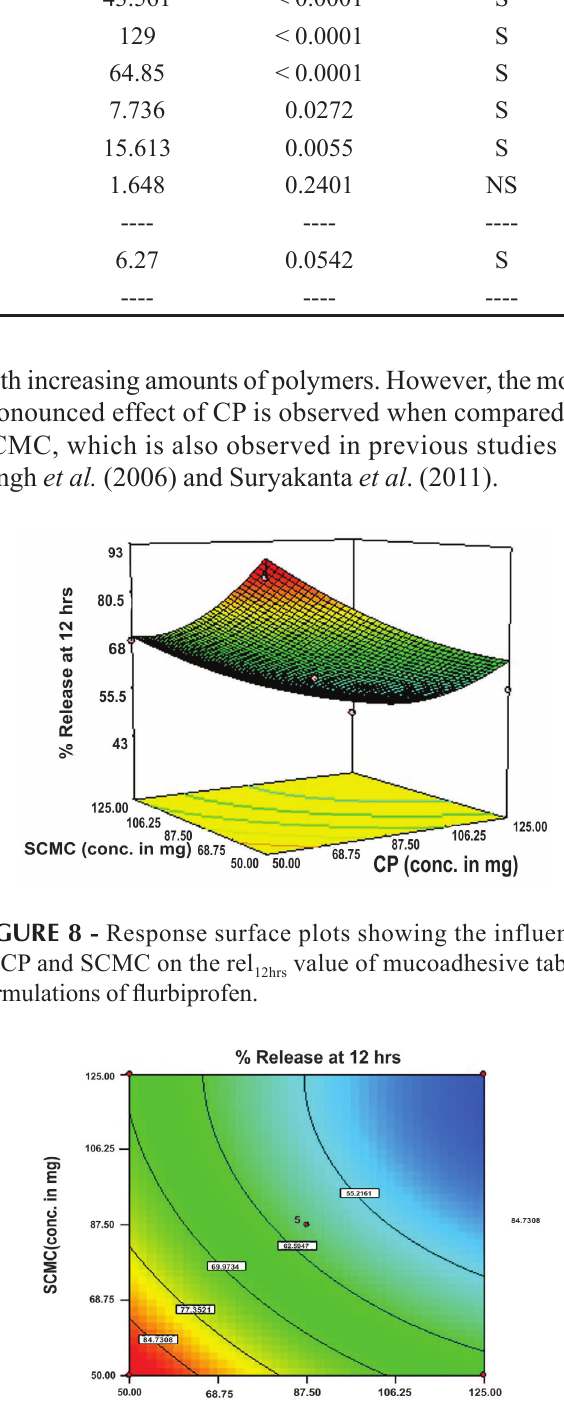
TABLE VIII - Analysis of variance for Y Source